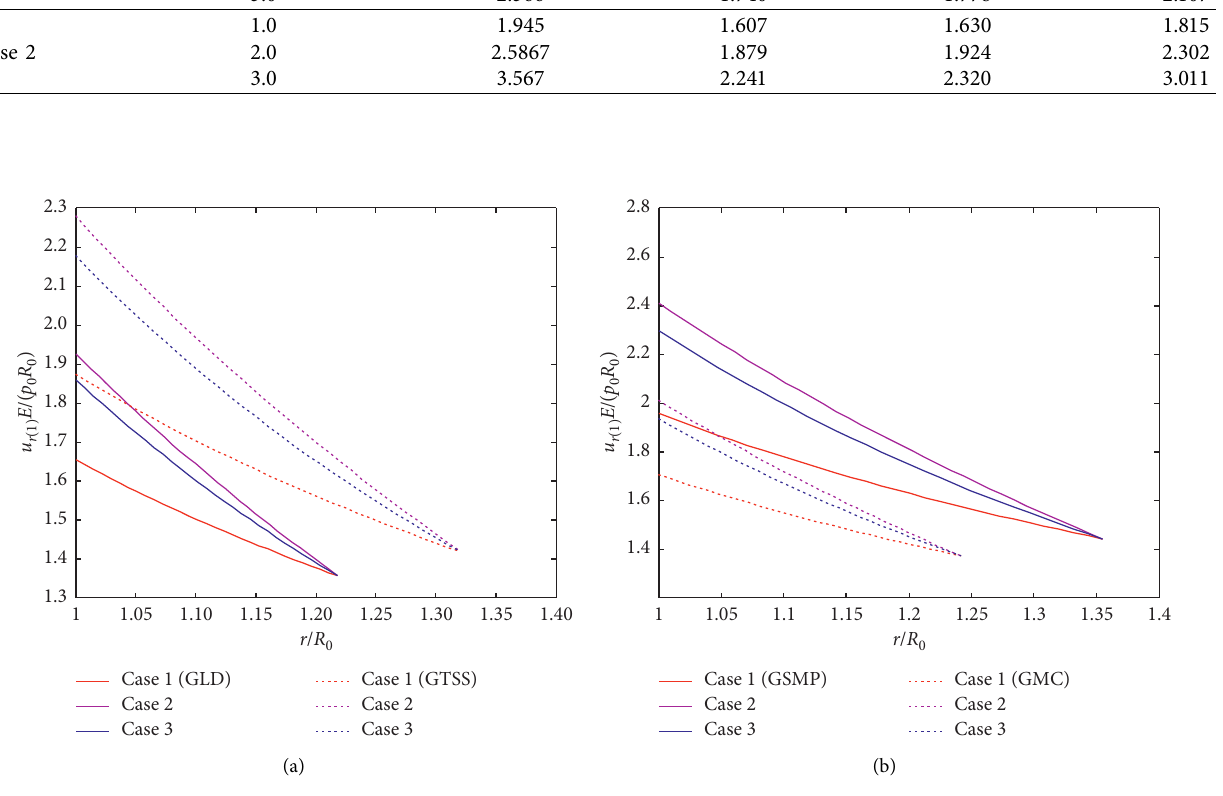
Figure 10: The effect of elastic strain form on the radial